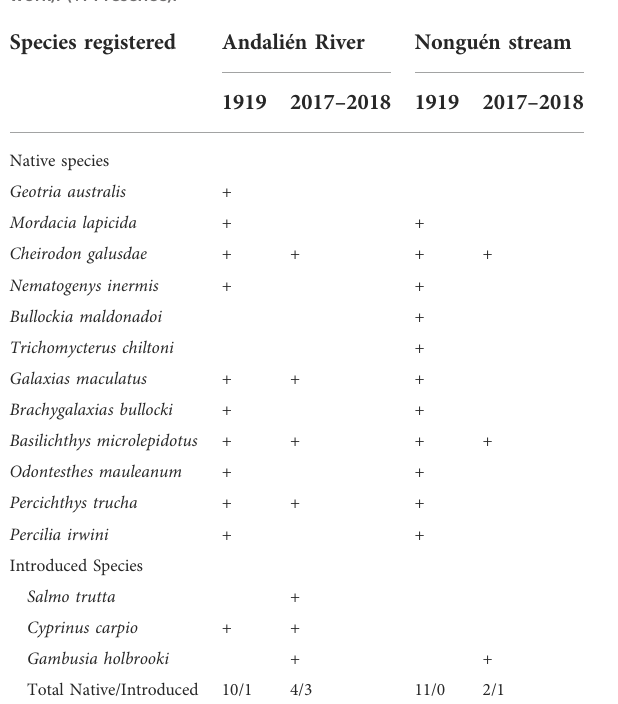
TABLE 2 Comparison of fi sh assemblage composition in the potamon areas of the Andalién River and Nonguén stream between the 1919 campaigns by Oliver (1949) and the ones in 2017 and 2018 (this work). (+: Presence).